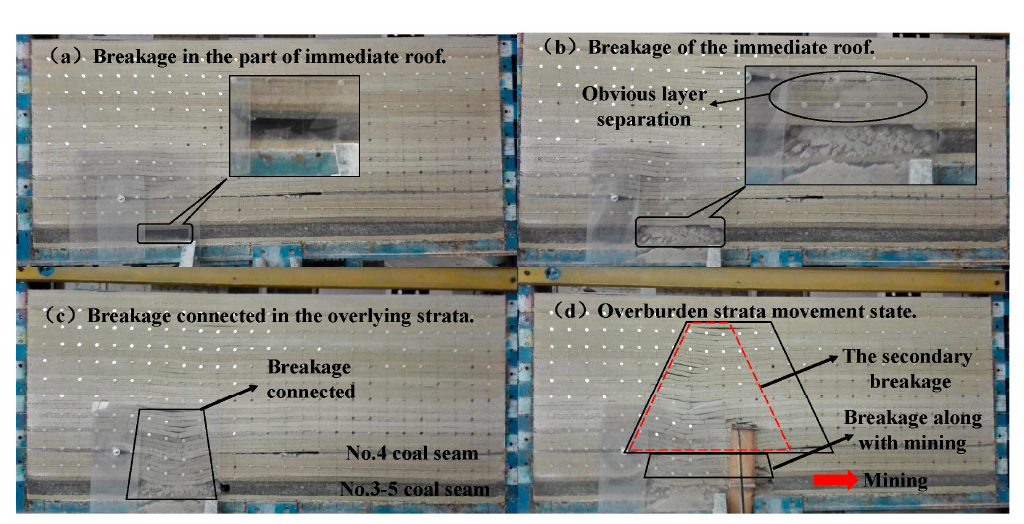
Figure 10. Fracture characteristics of strata while mining the No. 3–5 coal seam.